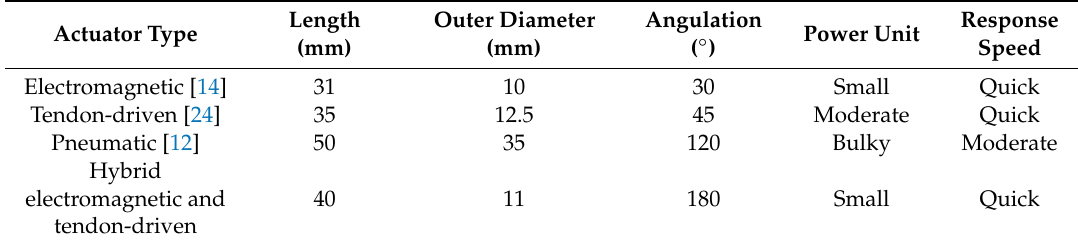
Table 4. Performance of di ff erent actuators for